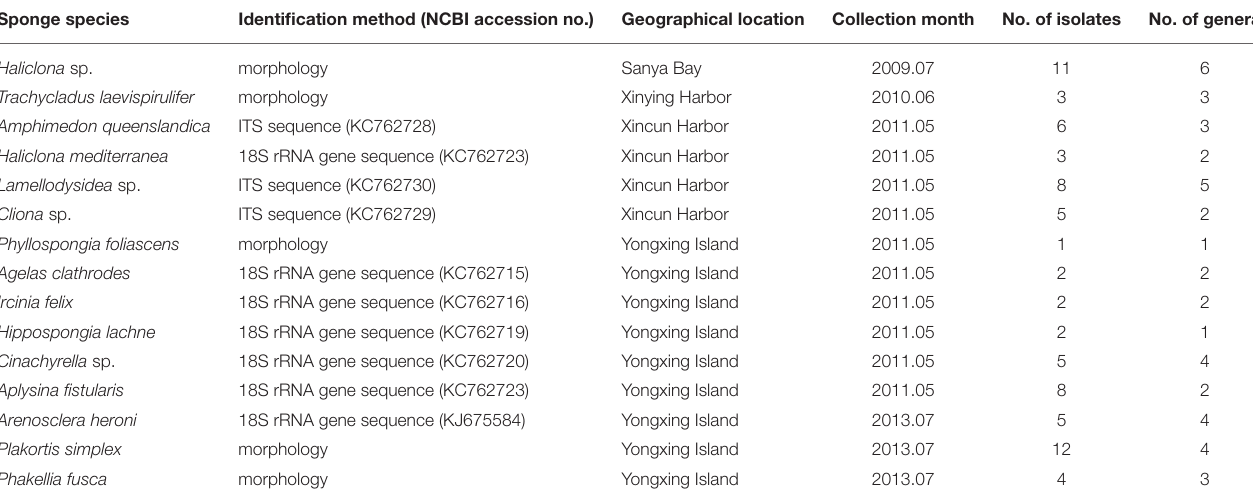
TABLE 1 | Sponge samples collected from the South China Sea and their actinomycete isolates. Sponge